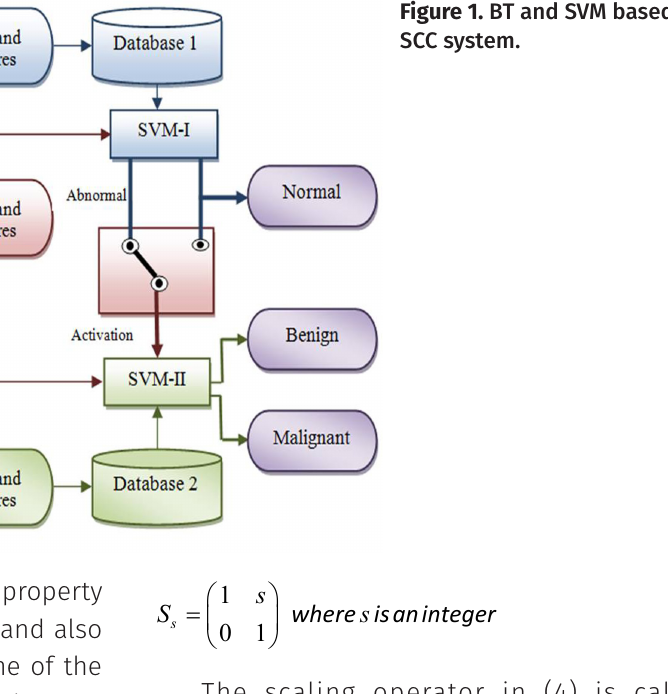
Figure 1. BT and SVM based SCC